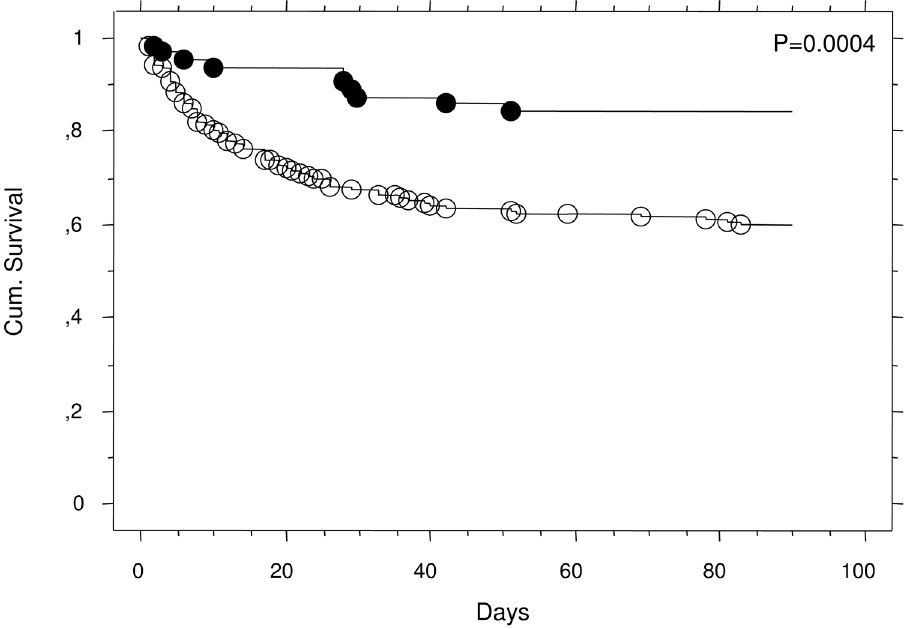
Figure 4. Kaplan-Meier plot of 90 day survival after admission to the ICU in patients with SIRS or sepsis is shown. Closed circles indicate PTX3 levels below the 25th percentile, while open circles indicate PTX3 levels above the 25th percentile (log rank, p=0.0004). The 25th percentile corresponds to a PTX3 level of 32.6 ng/ml.